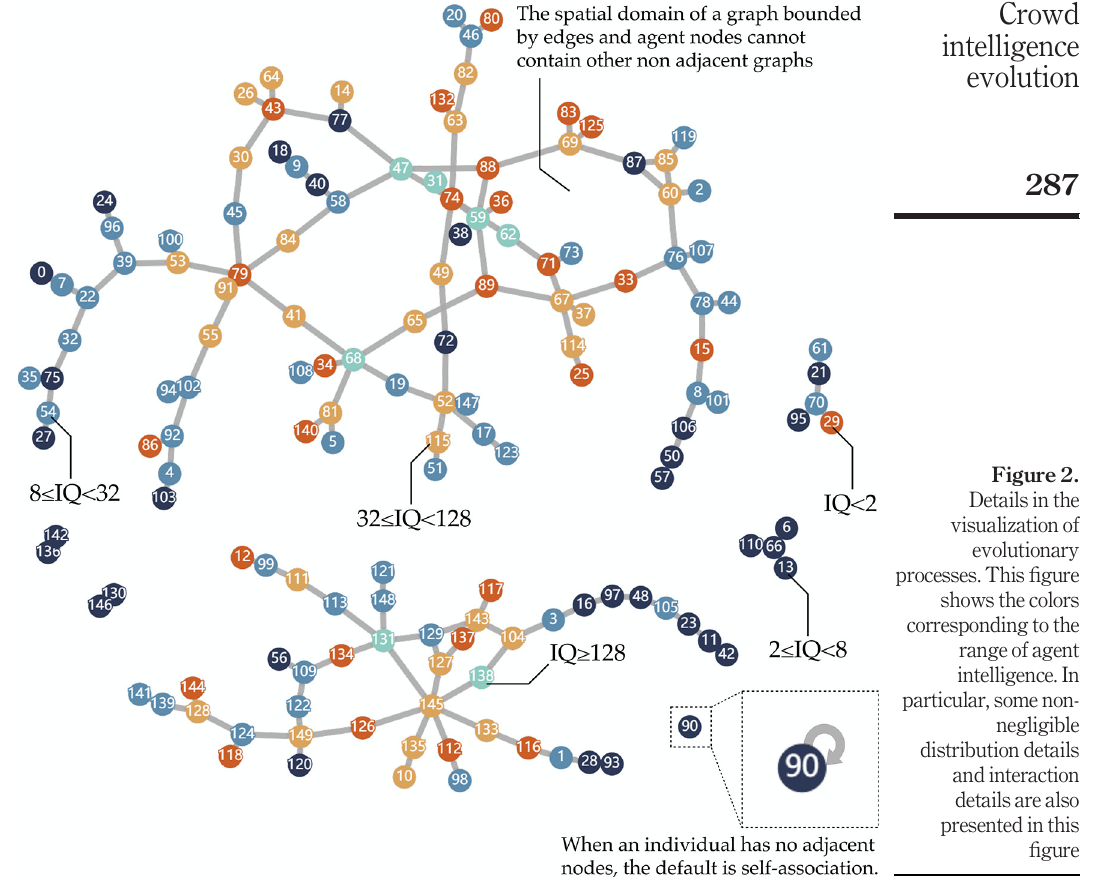
Figure 2. Details in the visualization of evolutionary processes. This fi gure shows the colors corresponding to the range of agent intelligence. In particular, some non- negligible distribution details and interaction details are also presented in this fi